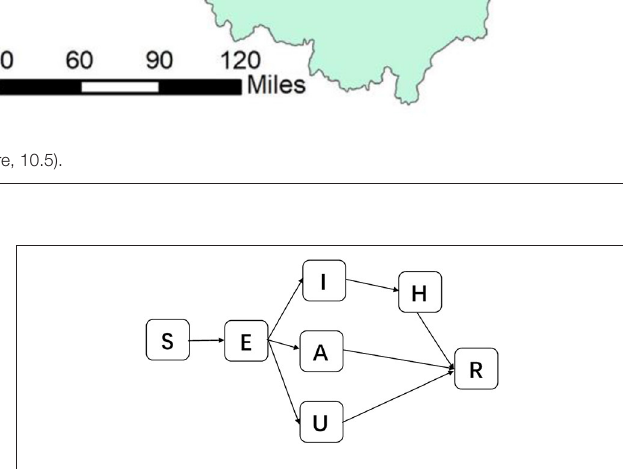
FIGURE 2 | Schematic diagram of SEAIUHR model propagation process. S, susceptible; E, latent; A, asymptomatic infectious; I, confirmed symptomatic infectious; U, unconfirmed symptomatic infectious; H, hospitalized; R, removed.